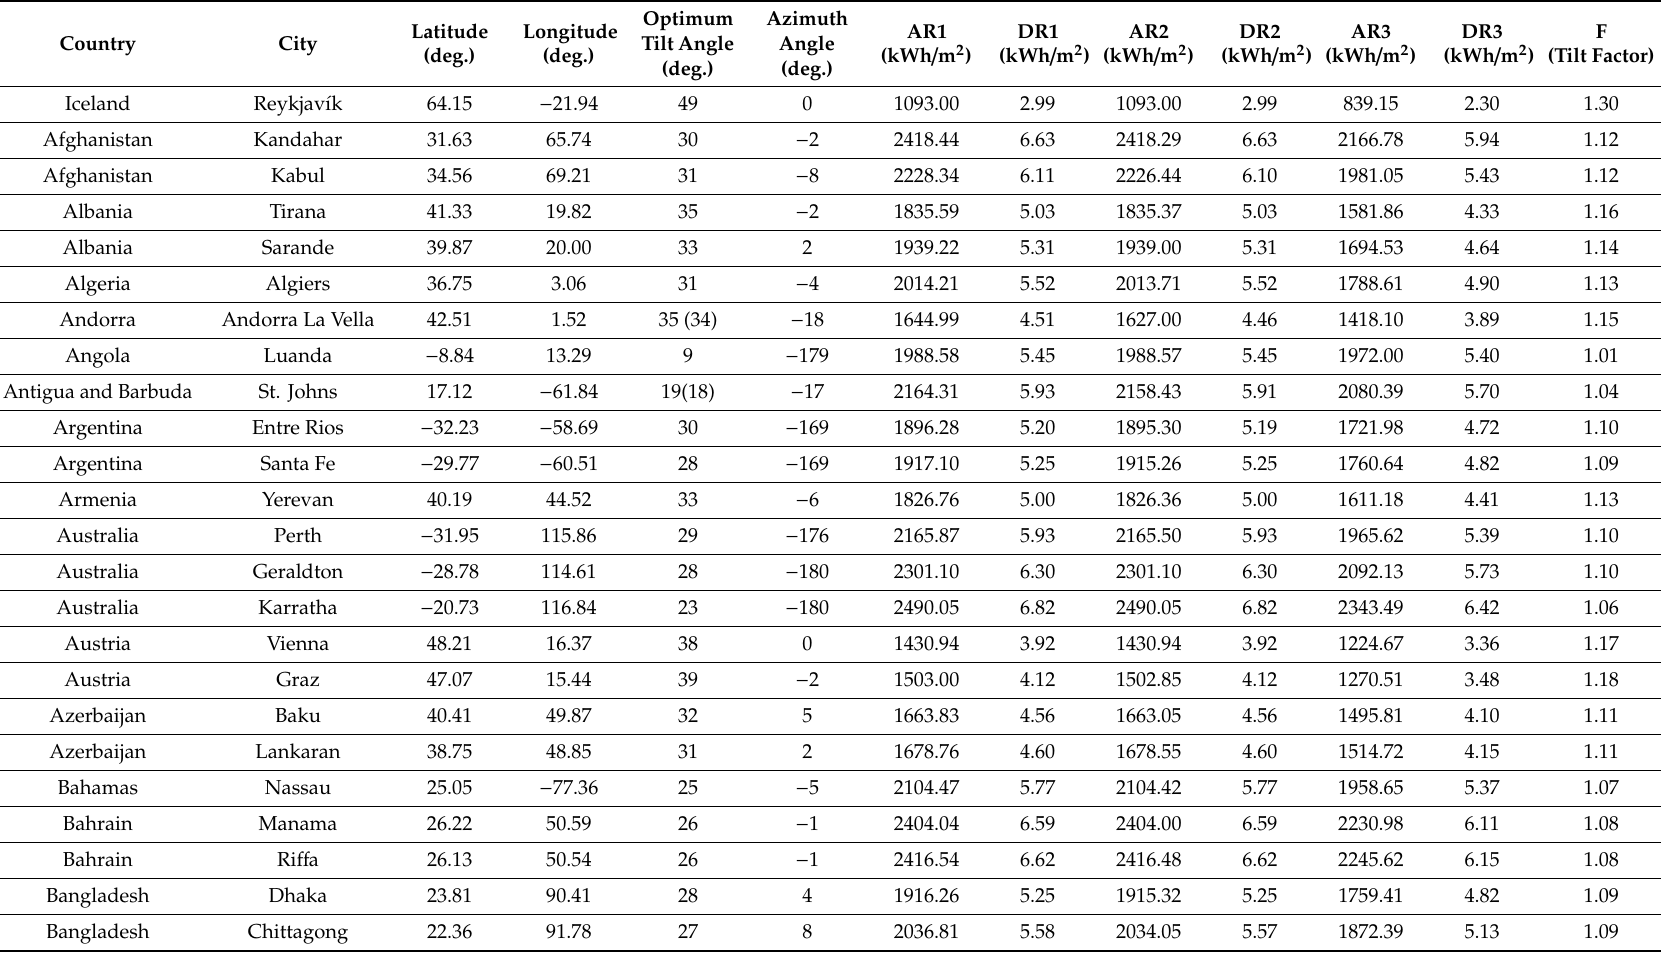
Table A1. Optimum tilt and azimuth angles for PV panels, AR1, AR2, AR3, DR1, DR2, and DR3 for all countries of the